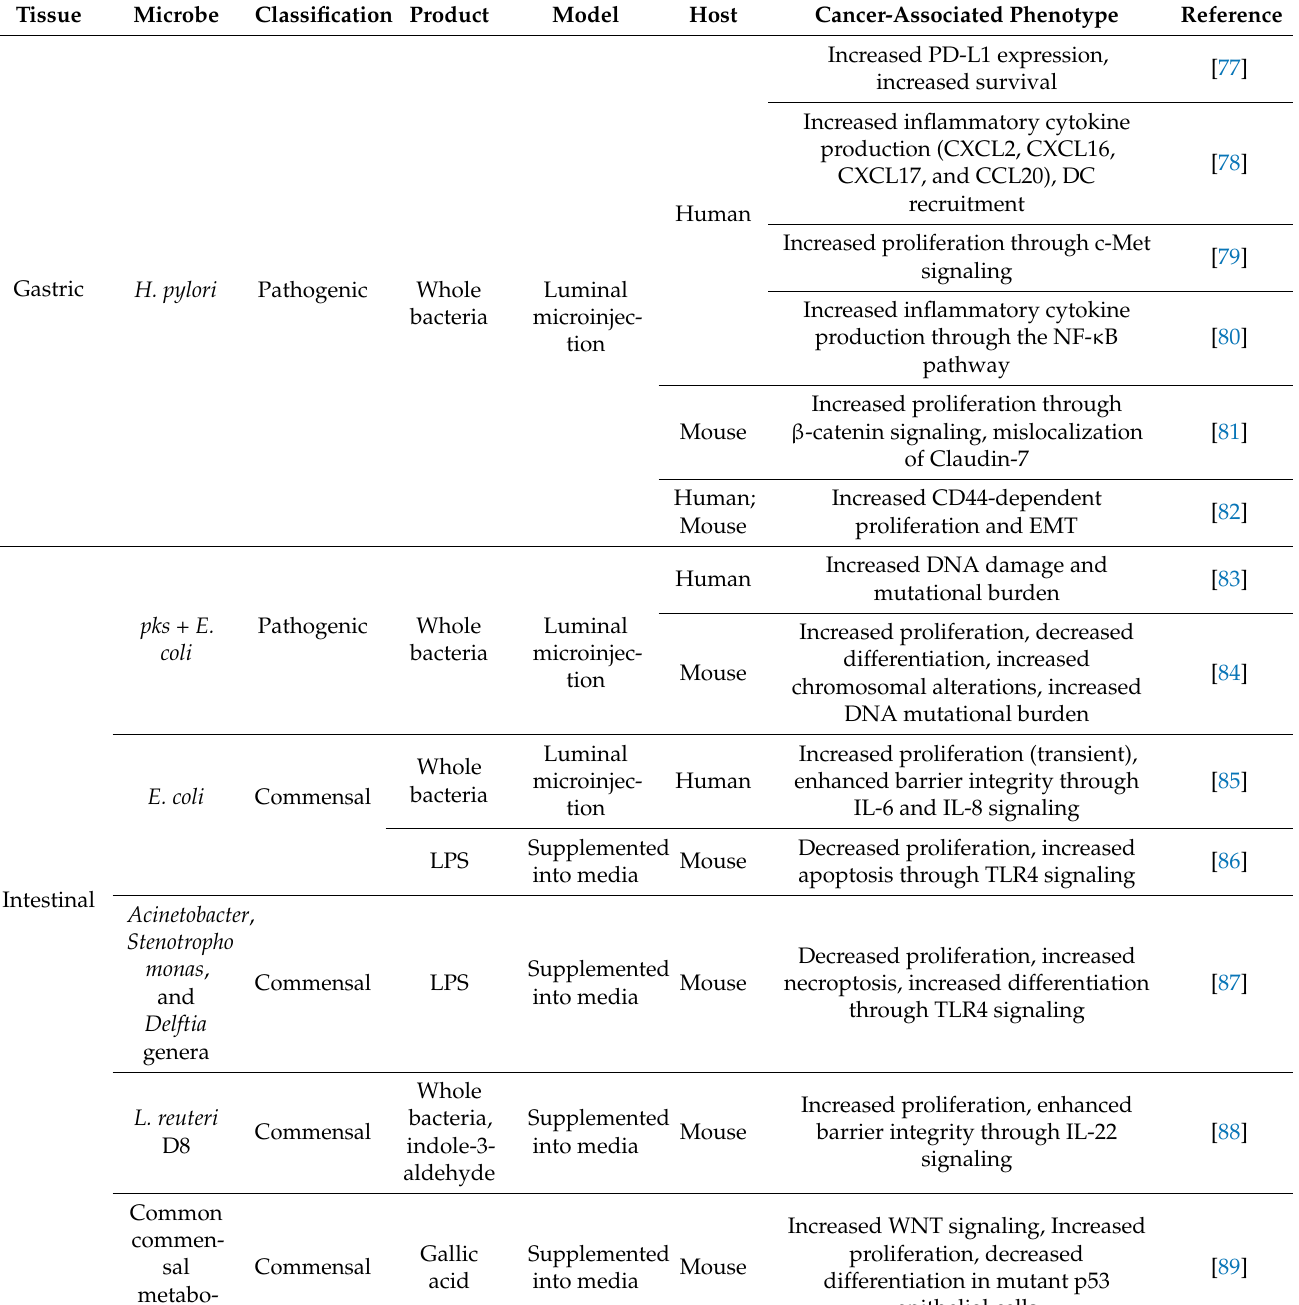
Table 1. Organoid and microbiome co-culture models of GI cancer-relevant